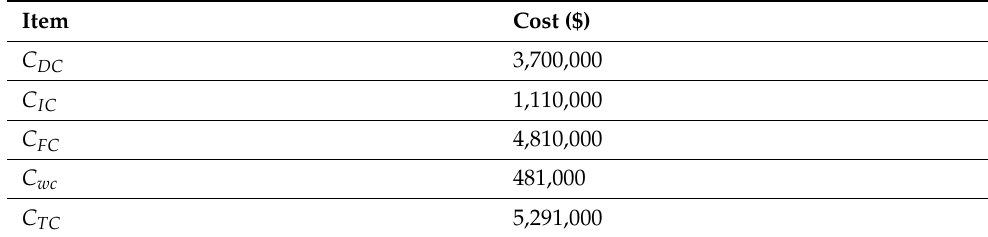
Table 3. Total capital cost ( C TC ) of a 1000 t/y DSO biodiesel production plant.